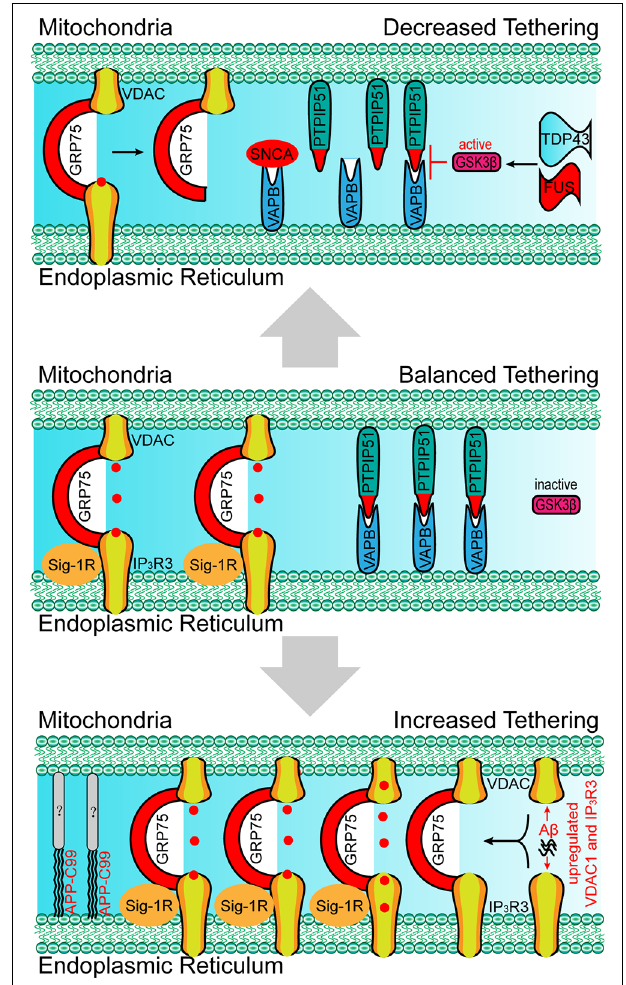
FIGURE 4 | Paradigm of changes in molecular determinants and ER-mitochondria tethering in neurodegenerative disorders. Upper: the absence of Sig-1R at MAM leads to the de-stabilization of IP 3 R3, resulting in the decreased IP 3 R3-GRP75-VDAC complex and ER-mitochondria tethering, which is associated with the development of amyotrophic lateral sclerosis (ALS). SNCA, FUS and TDP43 disrupt the VAPB-PIPTP51 interaction and ER–mitochondria contact, which is associated with the development of Parkinson’s disease (PD) and ALS. Bottom: the accumulation of A β at MAM promotes the expression of VDAC and IP 3 R3, which leads to the increased formation of the IP 3 R3-GRP75-VDAC complex, ER-mitochondria tethering, and mitochondrial Ca 2+ overload. APP-C99 is also observed at MAMs, which enhances the ER-mitochondrial contact. The presence of A β and APP-C99 at MAMs are associated with the development of Alzheimer’s disease (AD). SNCA, synuclein- α ; TDP43, TAR DNA-binding protein 43; FUS, RNA-binding protein FUS; A β , β